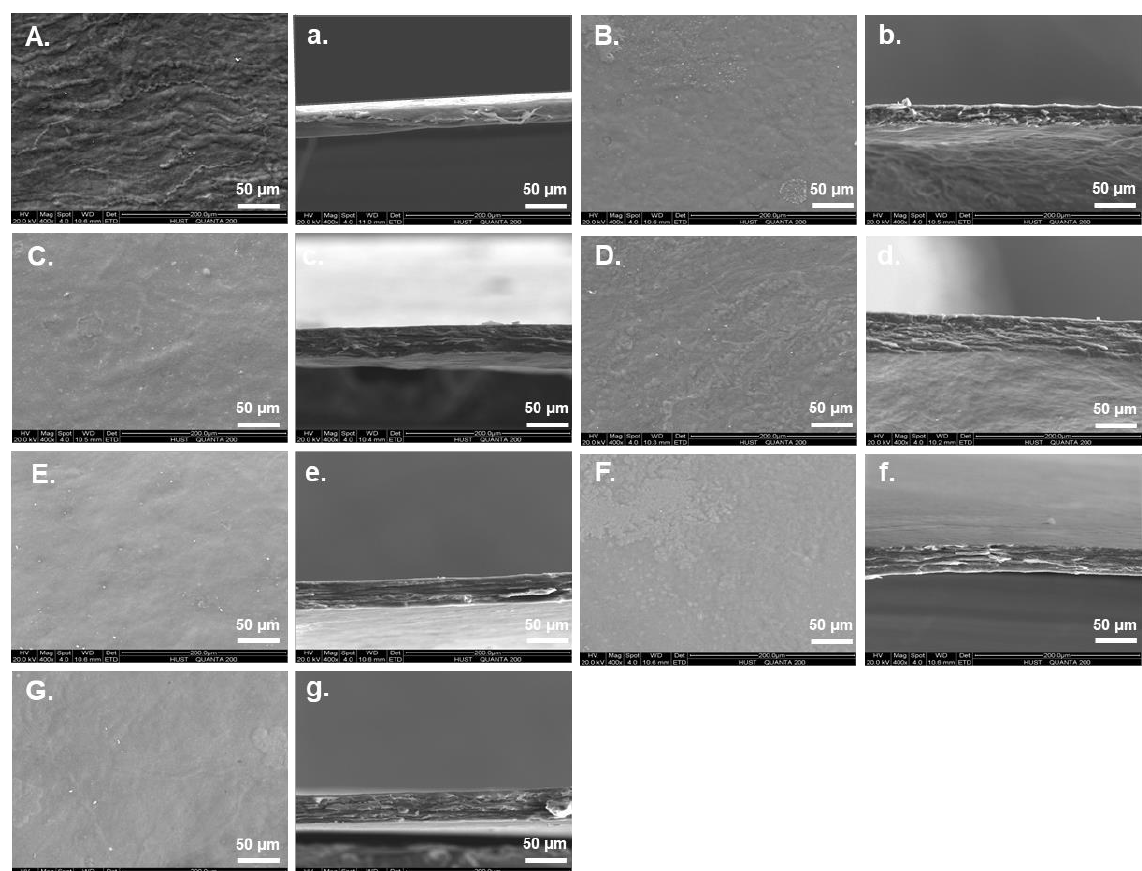
Figure 2. The SEM images (400×) of the collagen film surfaces ( A – G ) and cross-sections ( a – g ). A/a : Control (collagen film); B/b : collagen with none-modified APL film; C/c : collagen with C. echinulate FR3-modified APL film; D/d : collagen with G. lucidum EN2-modified APL film; E/e : collagen with P. ostreatus BP3-modified APL film; F/f : collagen with S. commune DS1-modified APL film; G/g : collagen with Xylariaceae sp. XY-modified APL film.